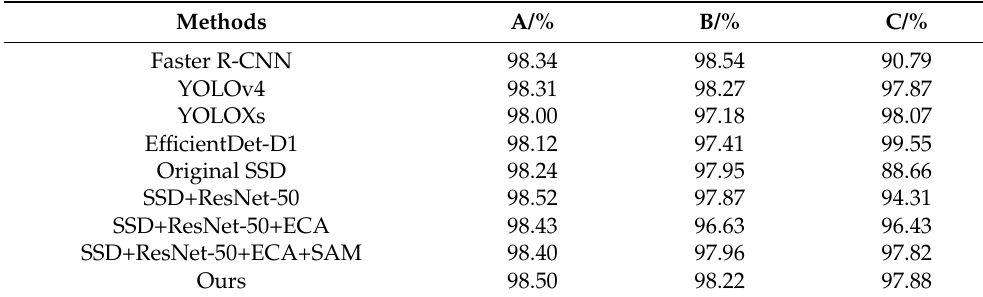
Table 3. Average precision (AP) comparison of different models.